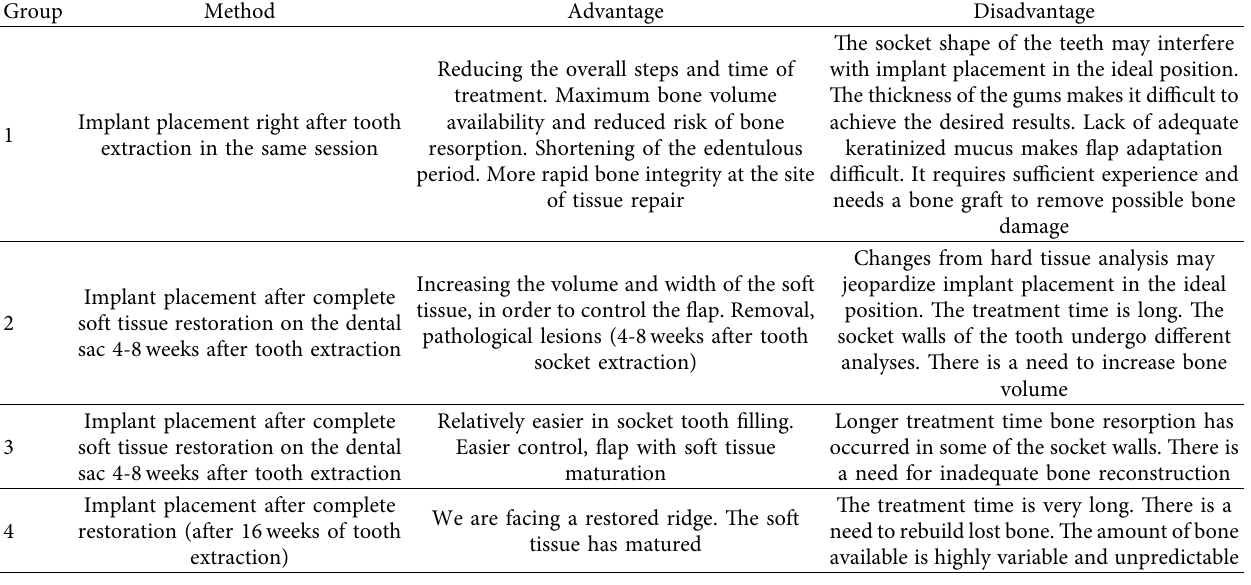
Table 1: Time intervals between tooth extraction and implant placement